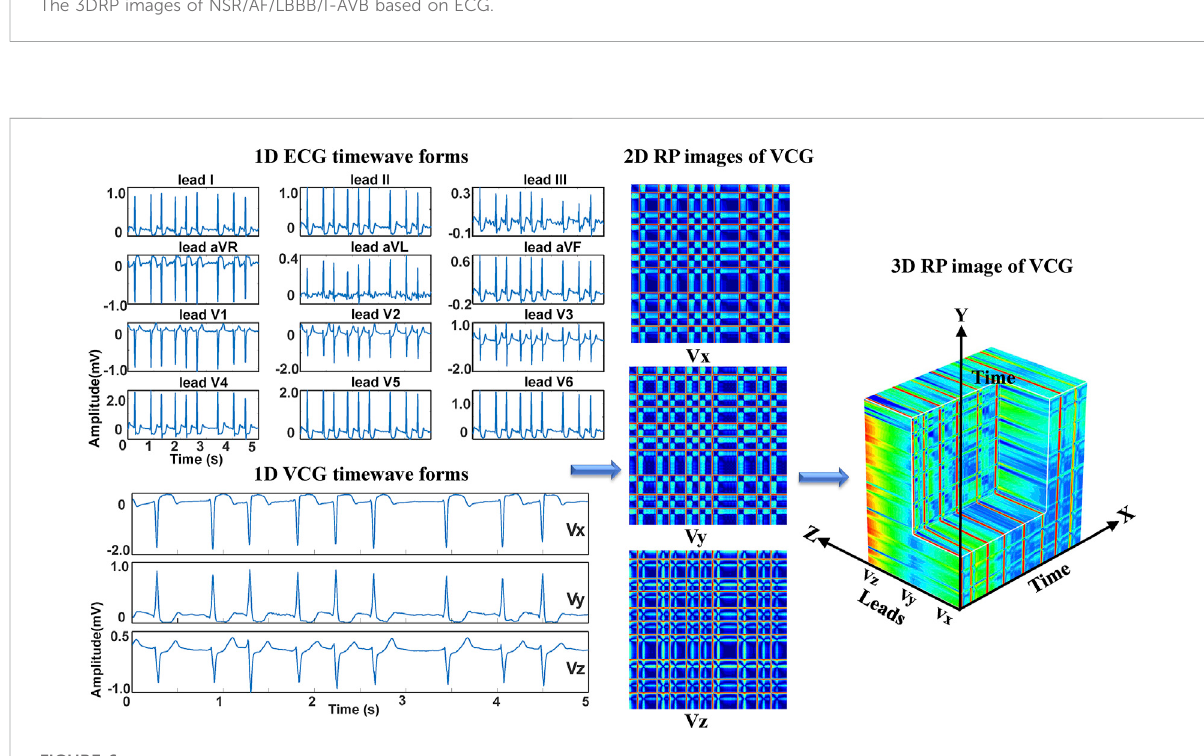
FIGURE 6 The 3DRP image reconstructed based on